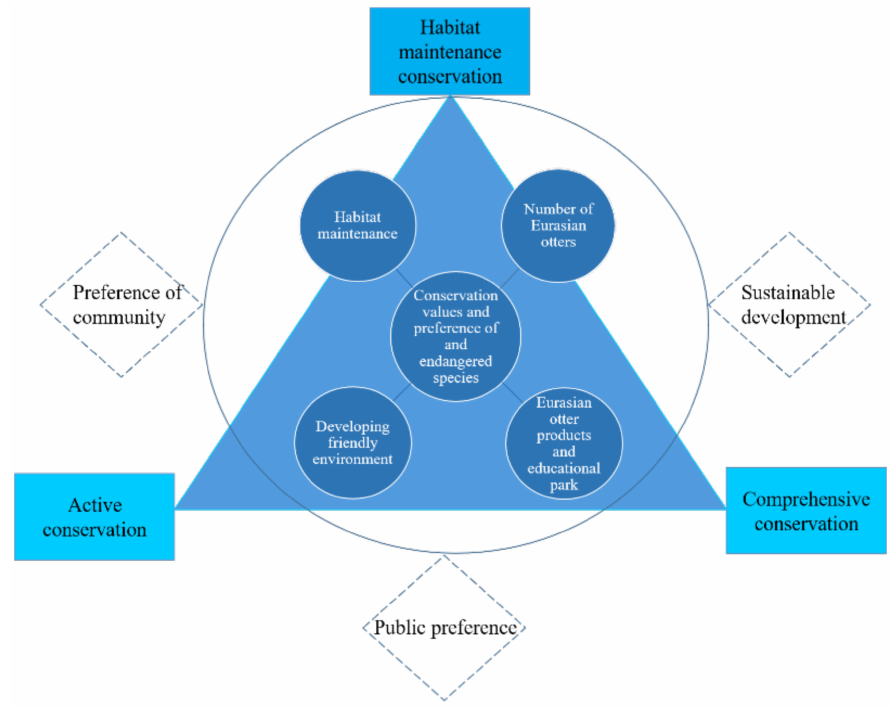
Figure 2. The conservation values and evaluation framework of endangered